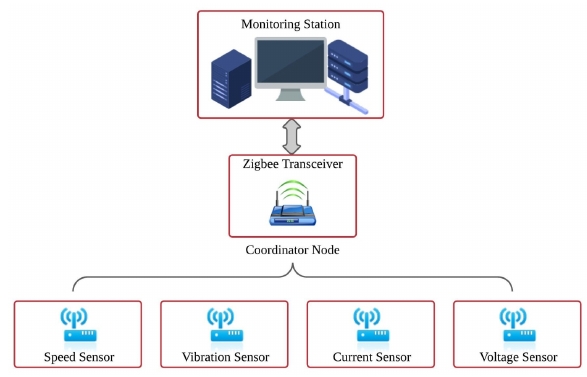
Figure 3: Experimental scenario for sensor and coordinator node